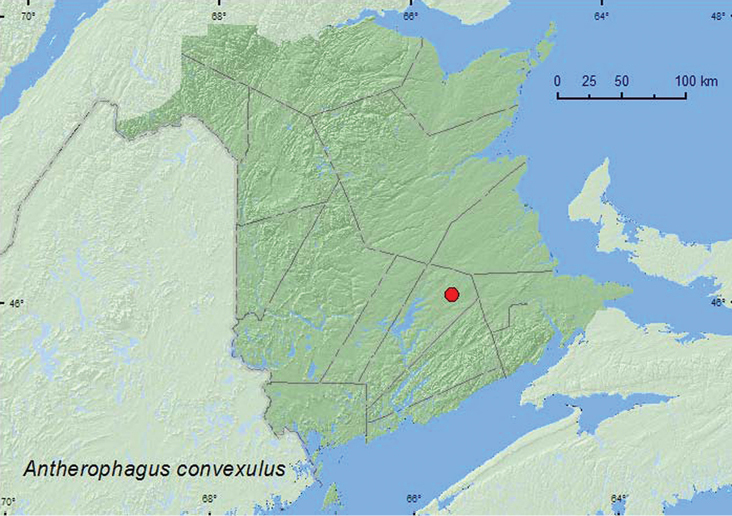
Collection localities in New Brunswick, Canada of Antherophagus convexulus